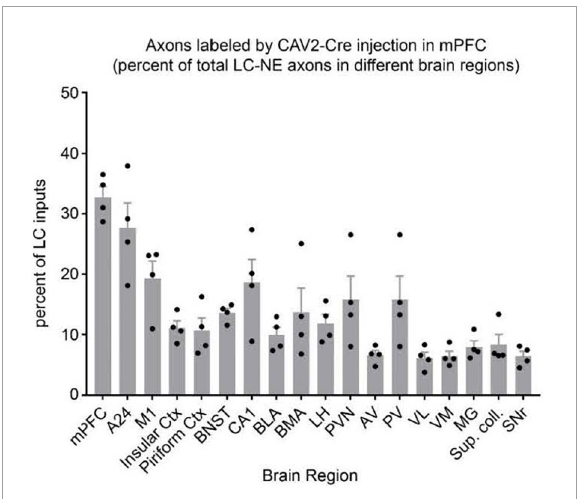
FIGURE4 Distribution of axon collaterals from LC neurons projecting to mPFC. The bar graph ( n = 4 mice) indicates percentage of LC-NE axons at each brain region that originate from EGFP + mPFC-projecting LC-NE neurons. LC-NE neurons are represented as percent of total LC-NE inputs (sum of EGFP + and tdTomato +) in select brain regions. mPFC, medial prefrontal cortex; A24, ventral anterior cingulate; insular ctx, insular cortex; M1, primary motor cortex; piriform ctx, piriform cortex; BNST, bed nucleus of the stria terminalis; CA1, area CA1 of the hippocampus; BLA, basolateral amygdala; BMA, basomedial amygdala; LH, lateral hypothalamus; PVN, paraventricular hypothalamic nuc; AV, anteroventral thalamic nuc; PV, paraventricular thalamic nuc; VL, ventrolateral thalamic nuc; VM, ventromedial thalamic nuc; MG, medial geniculate nuc; Sup. coll., superior colliculus; SNr, substantia nigra. Adapted from Plummer et al. (2020).